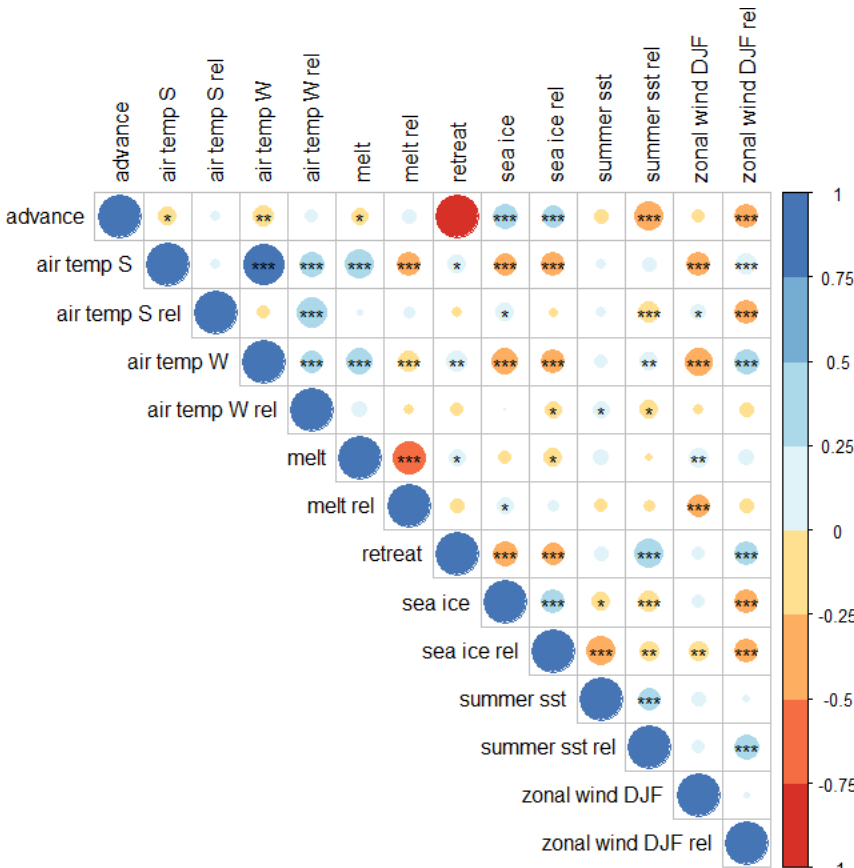
Figure 9. Correlation between glacier and ice shelf change and the analyzed climate variables winter and summer air temperature, snowmelt, sea ice days, summer sea surface temperatures, and zonal wind speed. Color and circle size indicate the correlation coefficient. Stars indicate significance levels for p = 0.05 ( ∗ ), 0.01 ( ∗∗ ), and 0.001 ( ∗∗∗ ). S: summer; W: winter; rel: relative to 1982–1996; DJF: